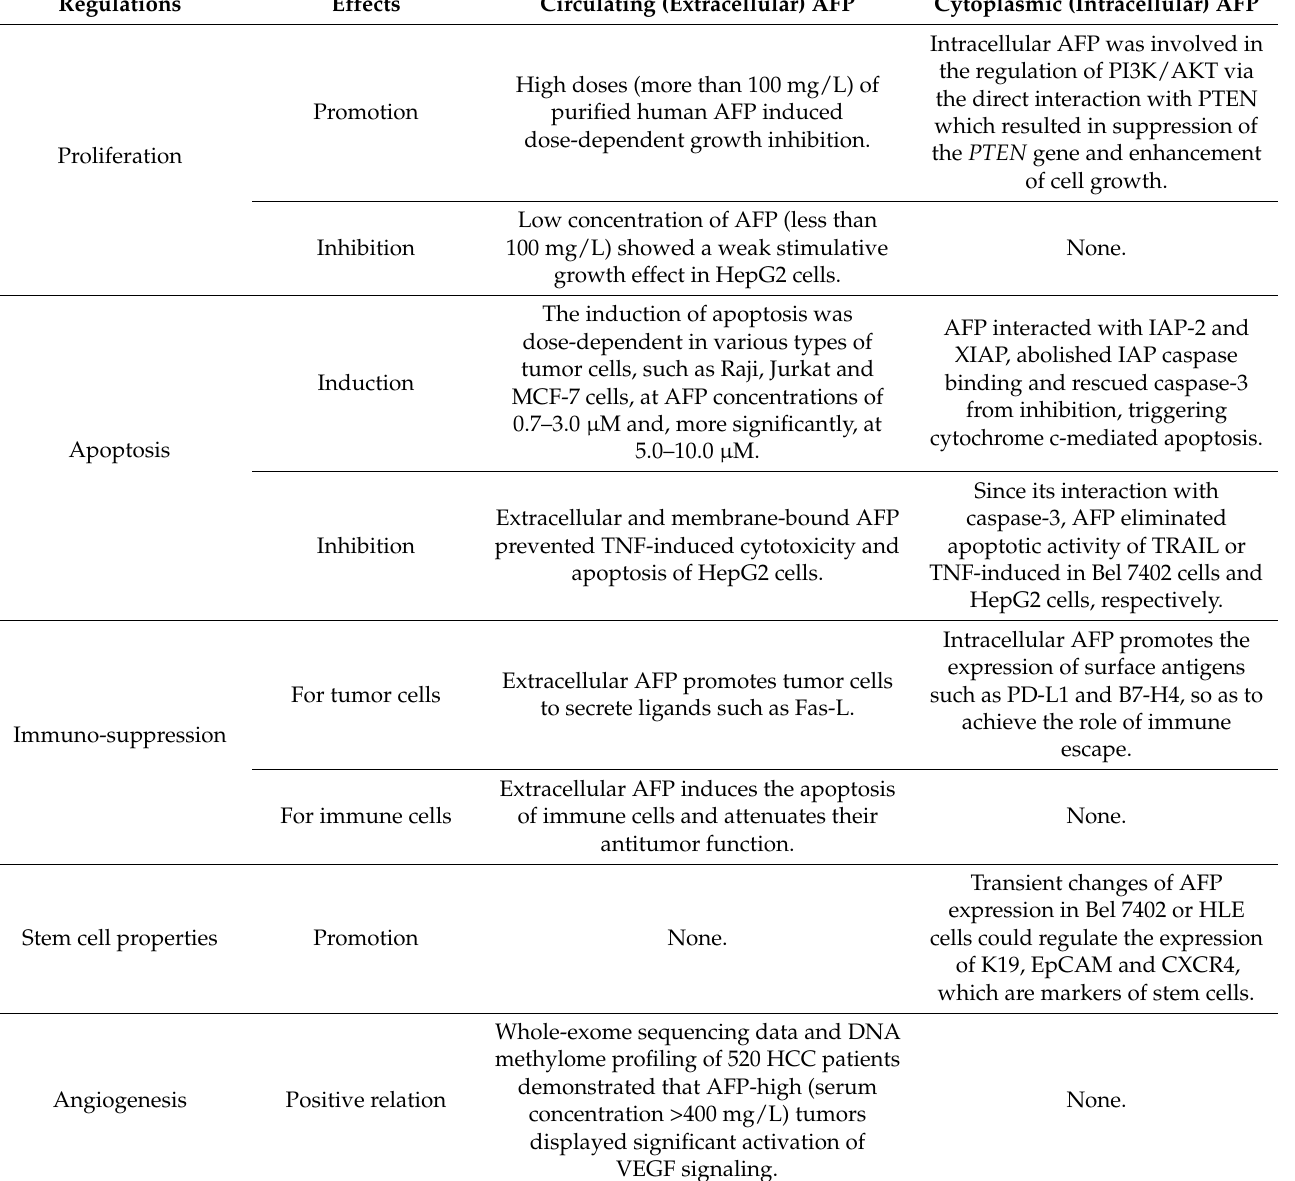
Table 2. Comparison between circulating (extracellular) and cytoplasmic (intracellular) AFP on the effects of the tumorigen- esis and progression of